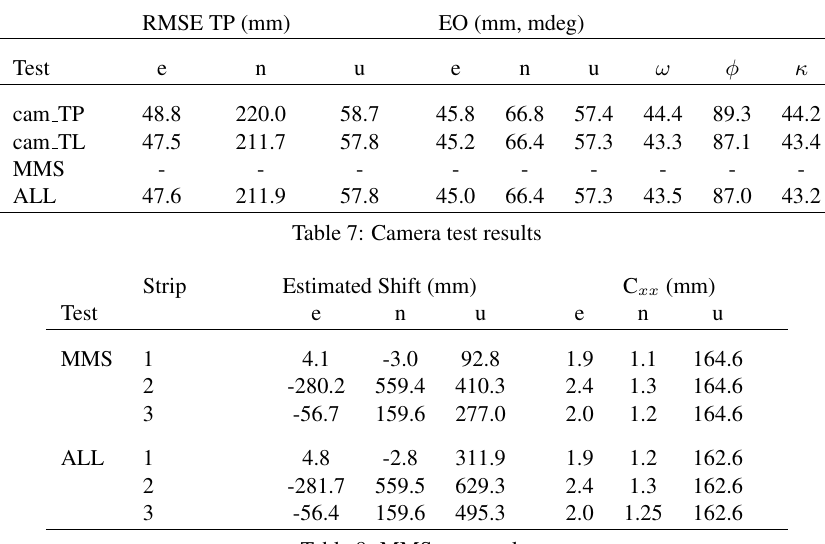
Table 6: Estimated parameters of block configurations.